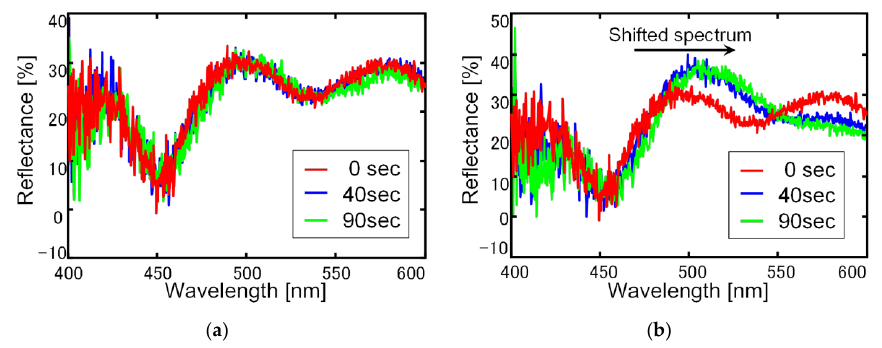
Figure 7. Change of the light reflection spectrum. ( a ) Sensor without parylene-AM and ( b ) sensor with parylene-AM.